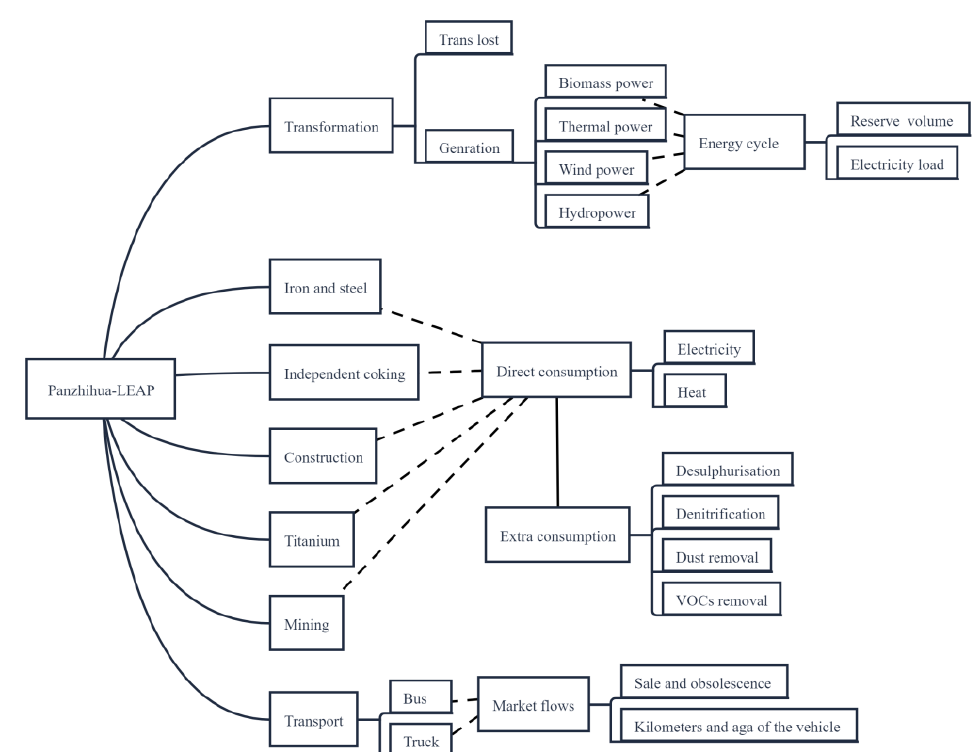
Figure 2. Structure of the Panzhihua LEAP model (this figure was constructed for this study) .